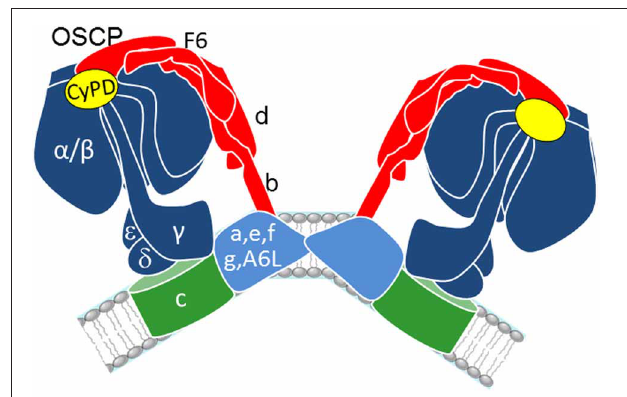
FIGURE 1 | Schematic representation of F O F 1 ATP synthase dimers. F 1 (dark blue), F O (green and light blue), and stalk subunits (red) are illustrated based on recent structural studies (Strauss et al., 2008; Baker et al., 2012; Davies et al.,